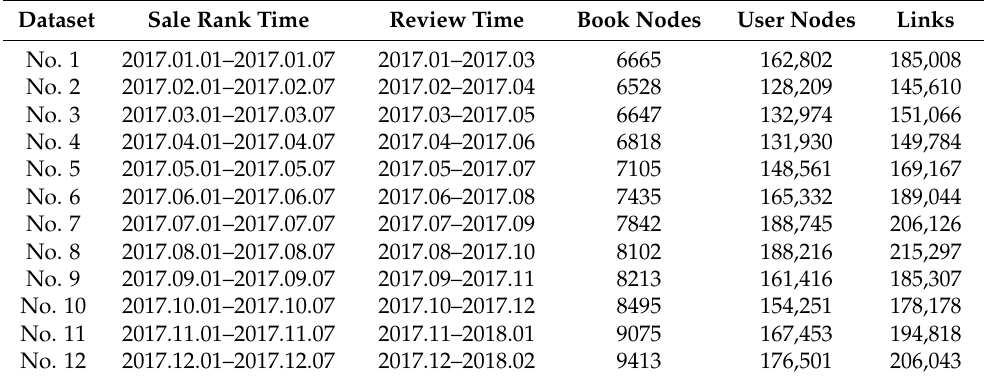
Table 2. Dataset related information in